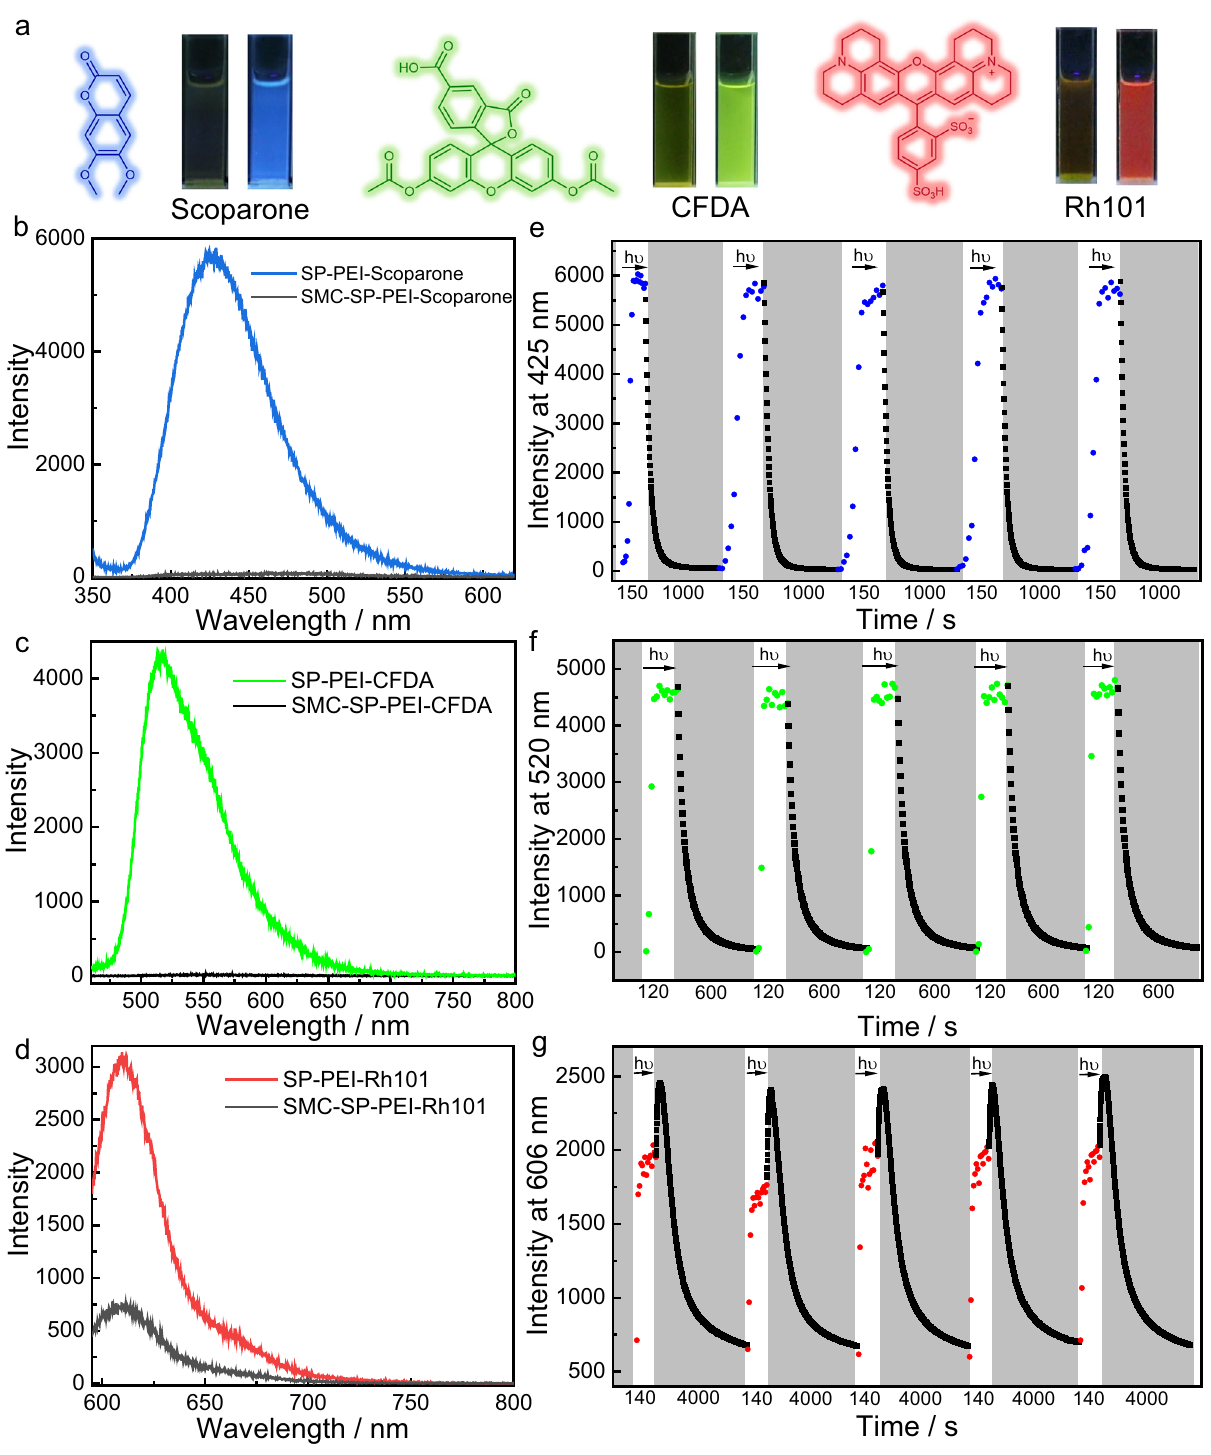
Fig. 6 Reversible cycles and kinetics of fl uorescence of scoparone, CFDA and Rh101 loaded in the supramolecular DSAs. a Chemical structures and their fl uorescence photographs of SMC-SP-PEI (left) and SP-PEI (right) loading scoparone (blue), CFDA (green) and Rh101 (red). b Fluorescence emission of SMEH-SP-PEI-scoparone and SP-PEI-scoparone. c Fluorescence emission of SMEH-SP-PEI-CFDA and SP-PEI-CFDA. d Fluorescence emission of SMEH- SP-PEI-Rh101 and SP-PEI-Rh101. e – g Reversible fl uorescence variation of scoparone at 425 nm, CFDA at 520 nm and Rh101 at 606 nm for 5 cycles between the SMC-SP-PEI and SP-PEI dissipative process over time. The white parts represent the light-induced formation of ASP-CS and the gray parts represents the dissociation process, respectively. ([SMC] initial = 0.225 mM, [PEI] = 5 μ g mL – 1 , [Scoparone] = 0.001 mM, [CFDA] = 0.01 mM, [Rh101] = 0.006mM, λ = 340 nm, λ = 440 nm, λ = 585 ex,Scoparone ex,CFDA ex,Rh101